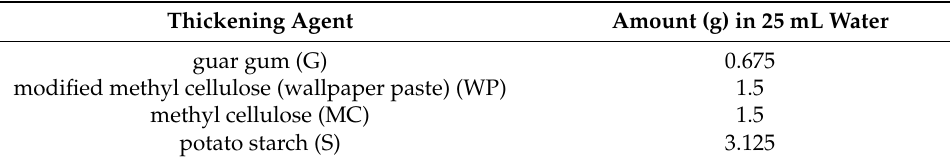
Table 1. Concentration of thickening agents in